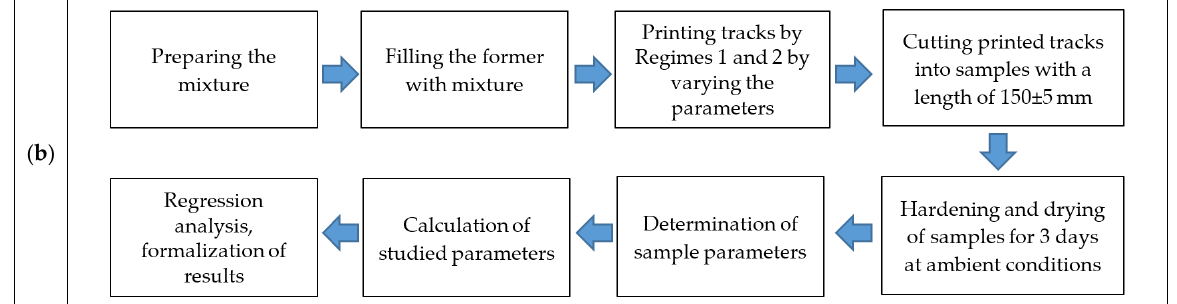
Figure 1. Laboratory 3D printer, designed in Belgorod State Technological University. V.G. Shukhov (Belgorod, Russia): 1—vertical screw blower; 2—hinged manually regulable vibrator;